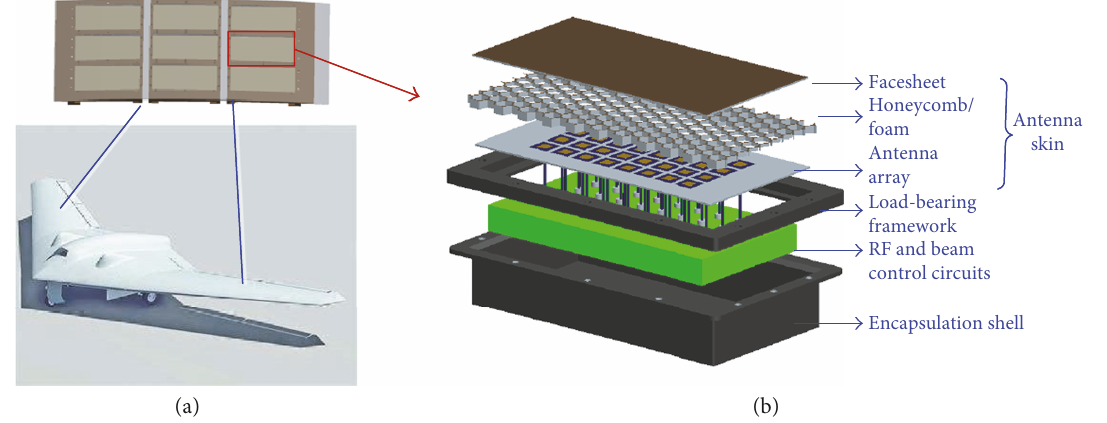
Figure 1: Schematic diagram of active skin antenna. (a) Application of active skin antenna. (b) Structural con fi guration of active skin antenna.